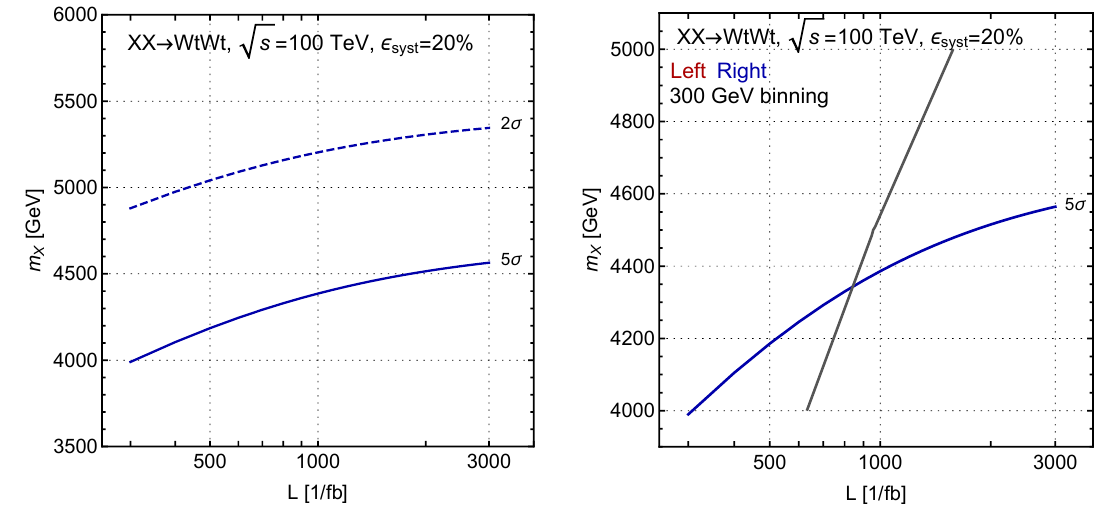
Figure 11 . Left panel: projected exclusion (dashed) and discovery (solid) reach of the same-sign dilepton search for a X VLQ decaying with 100% branching ratio into Wt for collider with an uncertainty on the background determination (cid:15) syst = 20%. Right panel: projected 5 (cid:27) discovery (blue) and 2 (cid:27) discrimination (gray) reach, using the p T distributionof the sub-leading lepton with a binning of 300